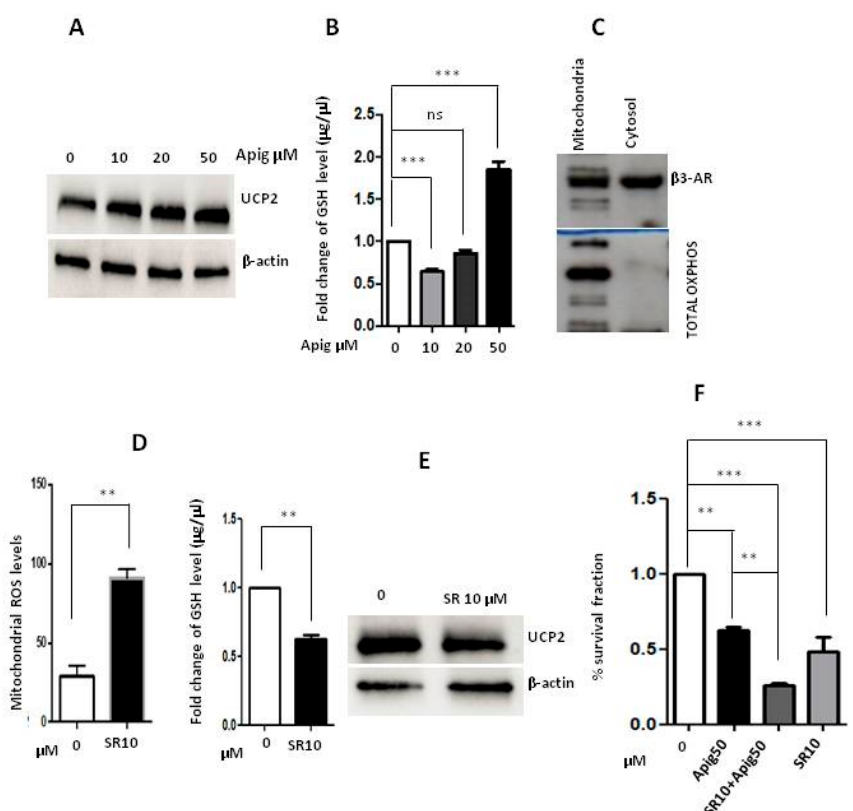
Figure 3. ( A ) Western Blot analysis of apigenin (10-20-50 μ M) effect on UCP2 expression, with β -actin as loading control; ( B ) Measurement of reduced glutathione levels (GSH) after 24 h of treatment with apigenin; ( C ) WB analysis of β 3-AR on mitochondria proteins; ( D ) Mitochondria mtROS measurement after treatment with β 3-AR antagonist, SR59230A, at the concentration of 10 μ M and measurement of GSH levels at the same time and concentration of SR59230A; ( E ) WB analysis of UCP2 expression after treatment with β 3-AR antagonist SR59230A with β -actin as loading control; ( F ) MTT survival experiment with double treatment with SR59230A (10 μ M) and apigenin (50 μ M). SR10: SR59230A 10 μ M, Apig50: apigenin 50 μ M, ns: not significant. P values for treatments: ** p < 0.01 and *** p < 0.001. 2.3. The Agonism of β 3-AR Reproduces the Effect of Apigenin Even if β 3-AR antagonism increased the levels of ROS, apigenin treatment did not increase β 3-AR expression in A673 cells (Figure 4A), and so therefore we hypothesised that apigenin could work as β 3-AR agonist. To address this question, we analysed the expression of UCP2 and the GSH production under the agonism of β 3-AR with BRL37344 (10 μ M), and we observed an increased expression of the protein and production of GSH comparable to the treatment with apigenin 50 μ M (Figure 4B,C). Moreover, we observed that the expression of antioxidant levels was decreased after 24 h of treatment with BRL37344, and the same reduction was observed with apigenin treatment (Figure 4D). In addition, results clearly indicated that the agonism of β 3-AR dramatically decreased ROS levels after 24 h of treatment in the same way as the apigenin treatment (Figure 4E).